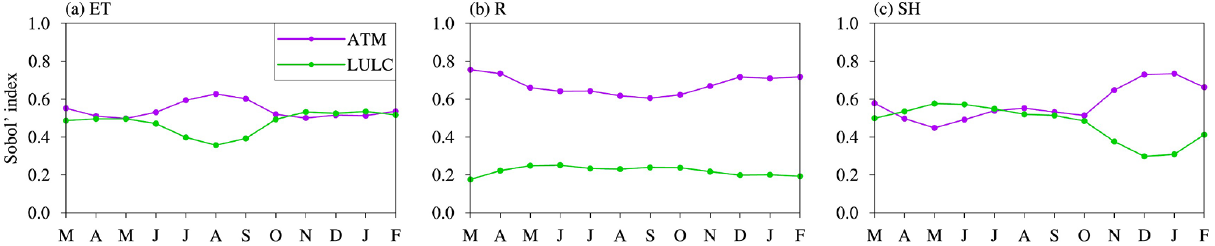
Figure 6. Monthly variations of CONUS-averaged ATM and LULC Sobol’ index for (a) ET, (b) R , and (c)